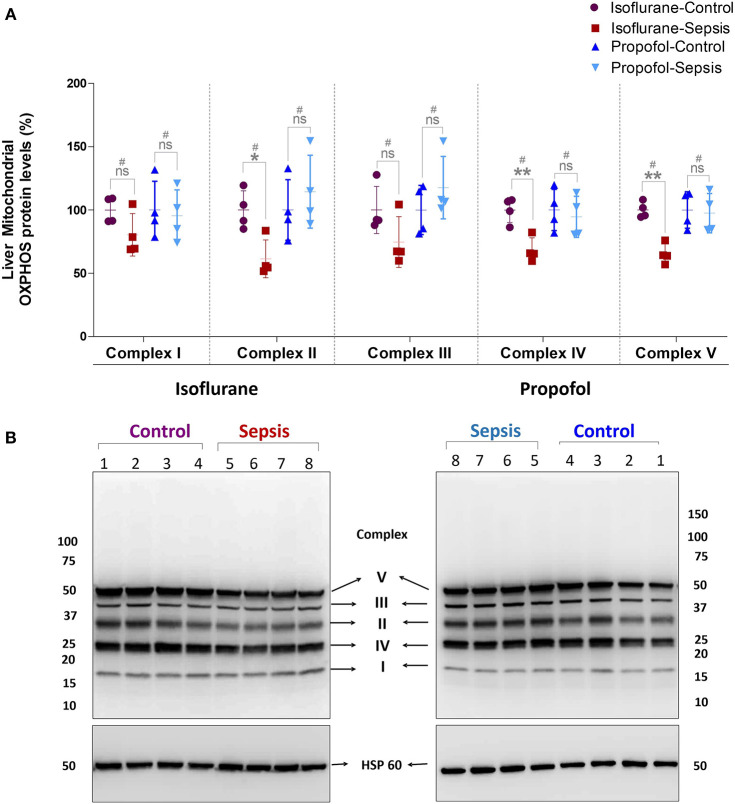
Effect of Sepsis with Isoflurane or Propofol anesthesia on Liver Mitochondrial Oxidative Phosphorylation (OXPHOS) Complex I-V, Protein expression levels. (A) Western blot analysis showing OXPHOS-Complexes I-V Protein levels, Complex-II (*p = 0.011), Complex-IV (**p = 0.003) and Complex-V (**p = 0.005) protein levels was significantly down regulated in isoflurane sepsis group and the complex protein expression levels are not significantly effected in Propofol Sepsis group. (B) A representative immuno blot displaying Complexes I-V Protein expression levels and HSP 60 (loading control). Complexes protein densities was quantified using Syngene –Gene Tools analysis software and expression levels was normalized with HSP60 and data presented in percentage. Values are mean ± S.D. (n = 4#/group). #represents pooled samples.